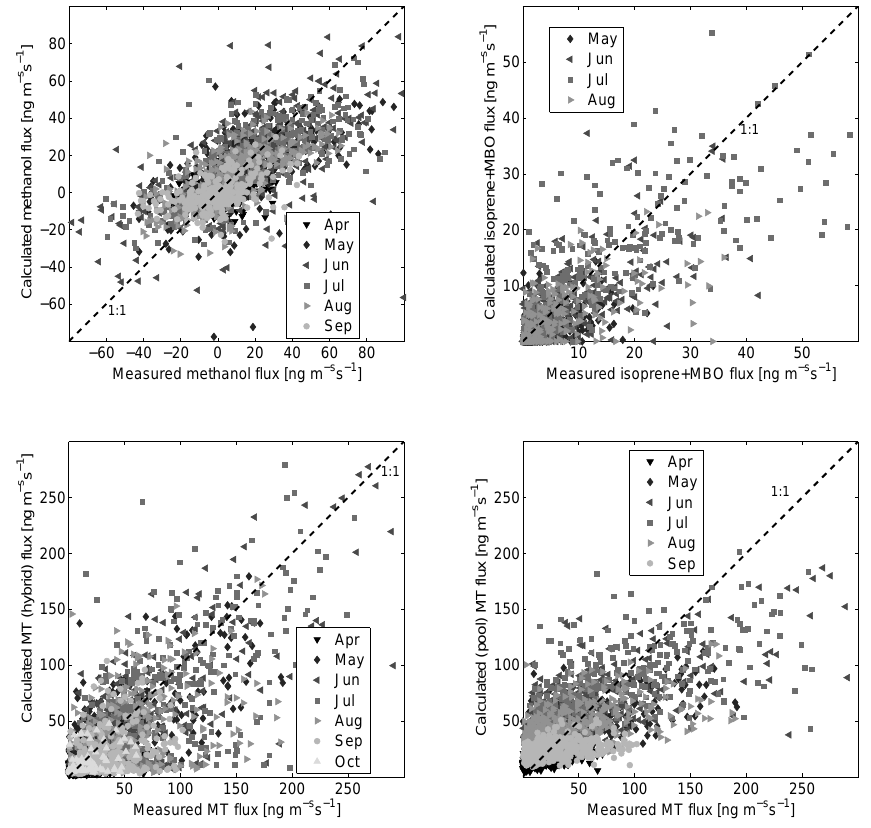
Figure 4. Calculated values versus measured methanol, isoprene and monoterpene fluxes for each month. Measured monoterpene fluxes have been compared against both hybrid and pool algorithm. Table 3. The table presents isoprene+MBO emission potential of a synthesis algorithm, E 0 , synth , including 95% confidence intervals (years 2010–2013). The table shows also correlations coefficients ( r ), relative errors between the measurements and the calculated values ( (cid:49)R ), and a ratio, F a /F , where F a is an average value given by the algorithm and F an average value of the measurements. If the p value of a correlation was larger than 0 . 0027, the result was disregarded as statistically insignificant, and those values are not shown in the table.